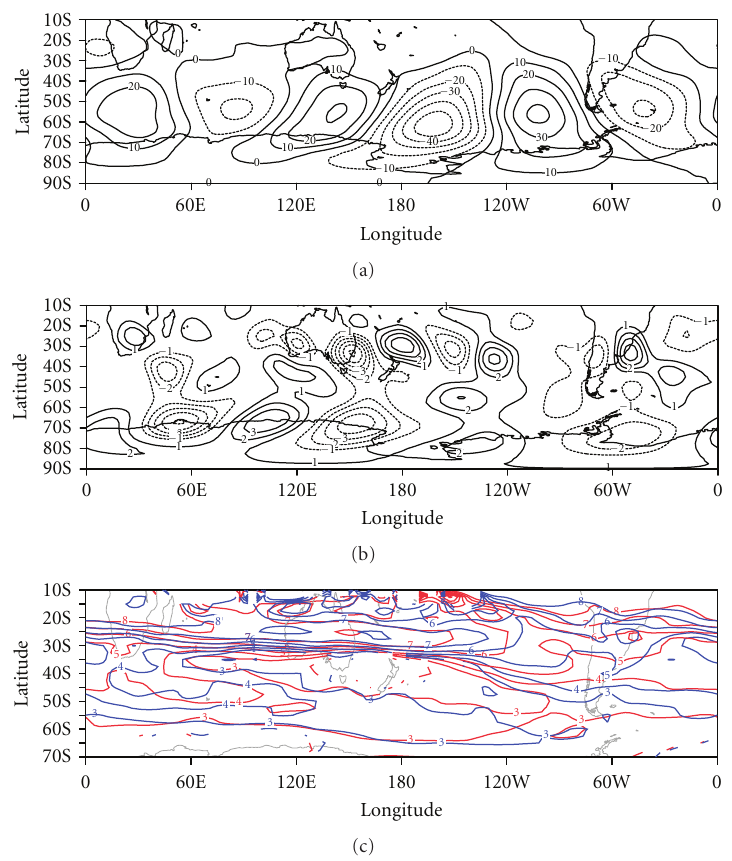
Figure 7: (a) Sum of stationary wave geopotential height anomalies for strong and weak HC cases, (b) sum of Rossby wave source anomalies for strong and weak HC cases, (c) stationary wavenumber ( K s ) at 300hPa for weak HC cases (red contours) and strong HC cases (blue contours). Contours at zonal wavenumbers 0, 1, 3, 4, 5, 6, 7, 8 and 25–30. The contour interval is 10 m in (a) and 1 × 10 − 11 s − 2 for